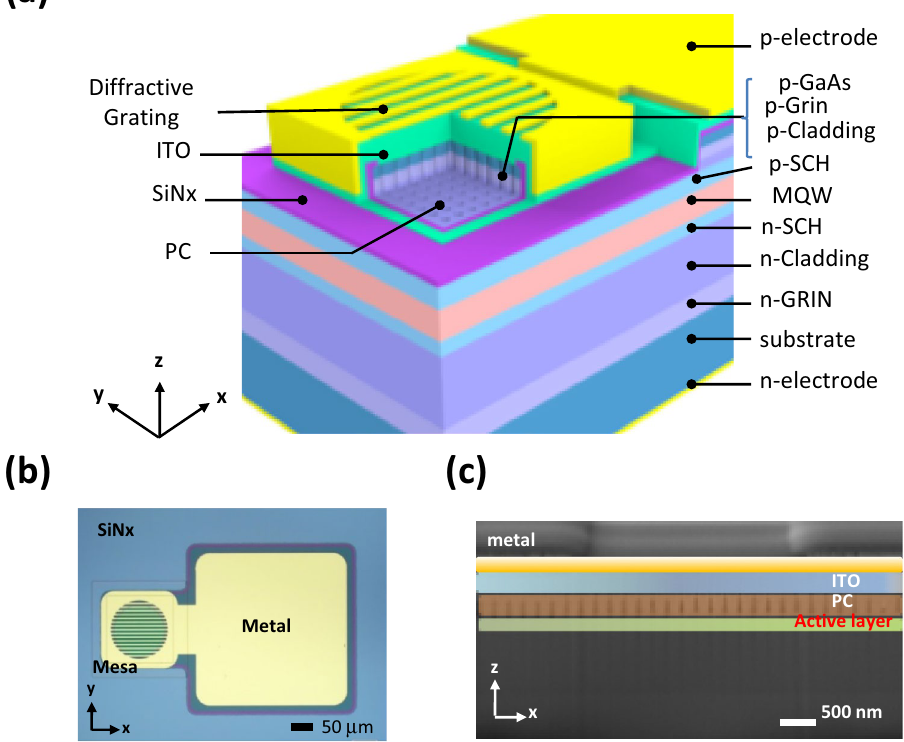
Figure 1. ( a ) Three-dimensional schematic diagram of a PCSEL with vertically integrated multiple diffractive elements. ( b ) The top-view image of the VIDG-PCSEL taken by an optical microscope. The metal grating is parallel to the x axis. ( c ) The cross-sectional scanning electron microscope image of the device with the metal grating and ITO periodic structure perpendicular to the x axis. The key layers are labeled and false-colored for easy identification. The ITO periodic structure is emphasized by blue and cyan colors according to the contrast of SEM image in the gray